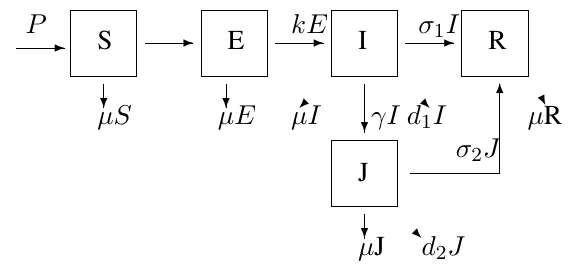
Fig. 1: Compartmental structure and flow chart for the